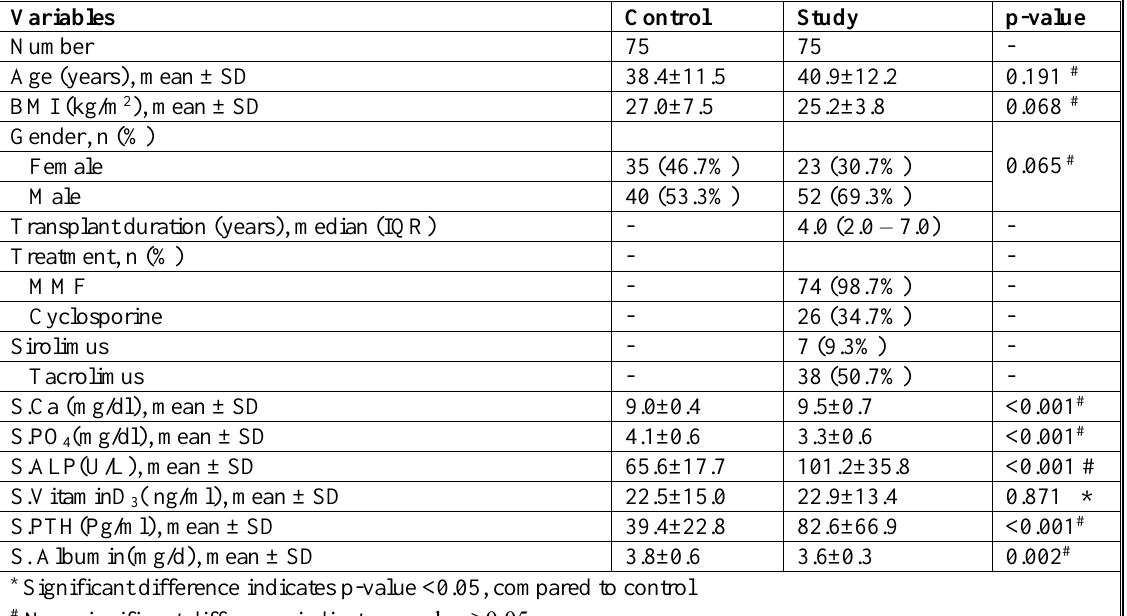
Table 1. Assessment of demographic, clinical, and laboratory